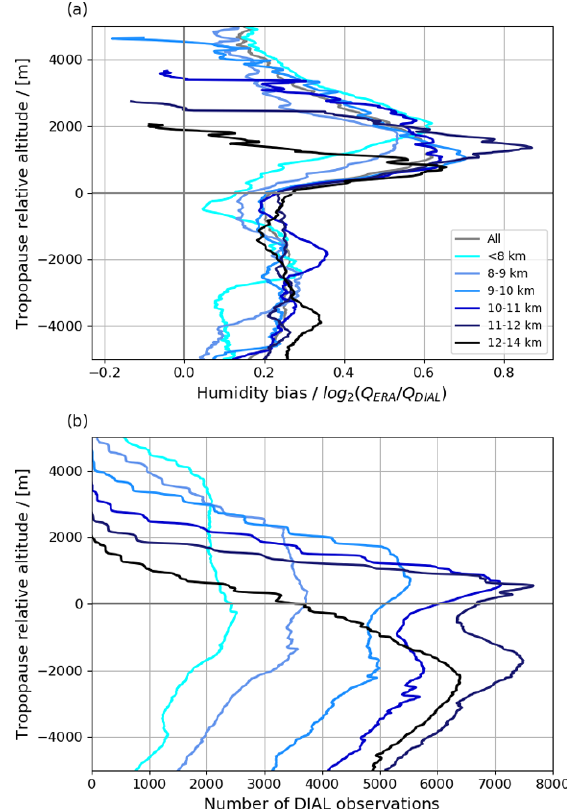
Figure 8. Tropopause-relative vertical profiles of (a) humidity bias and (b) number of observations for the different campaigns (colour- coded as in Fig. 1). The black line represents the multi-campaign average.